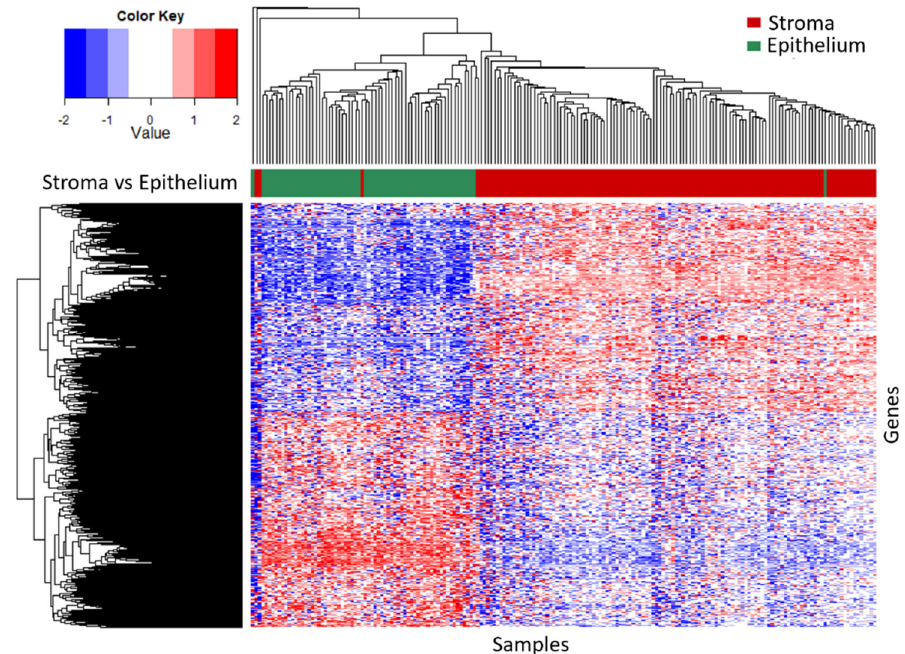
Figure A6. Heatmap and dendrogram showing the normalised and scaled (z-scored) expression levels of genes ( n = 8944) differentially expressed in PDAC stroma relative to the epithelium (FDR < 0.05) across n = 189 samples. Red and blue colours indicate increased and decreased expression, respectively.